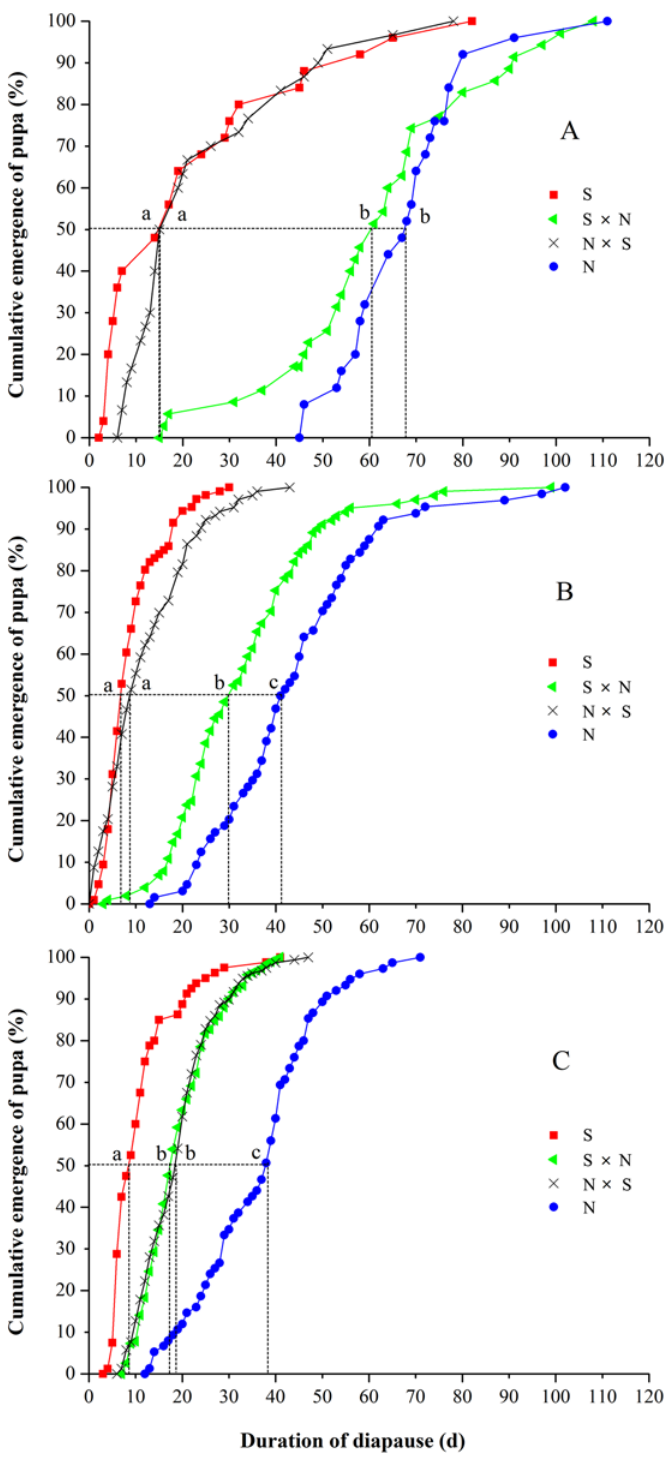
Fig 4. Termination of larval diapause in Ostrinia furnacalis for the northernmost Harbin strain (N × N) (females shown on the left), the southernmost Ledong strain (S × S), and their F 1 progeny (N × S, S × N) (n = 67 – 218) at (A) LD 12:12 h (a diapause-inducing photoperiod), (B) LD 16:8 h (a diapause- averting photoperiod) at 25°C and (C) LD 16:8 h, 25°C after being placed at 5°C for 92 days in continuous darkness. Diapause was induced at 22°C, LD 12:12